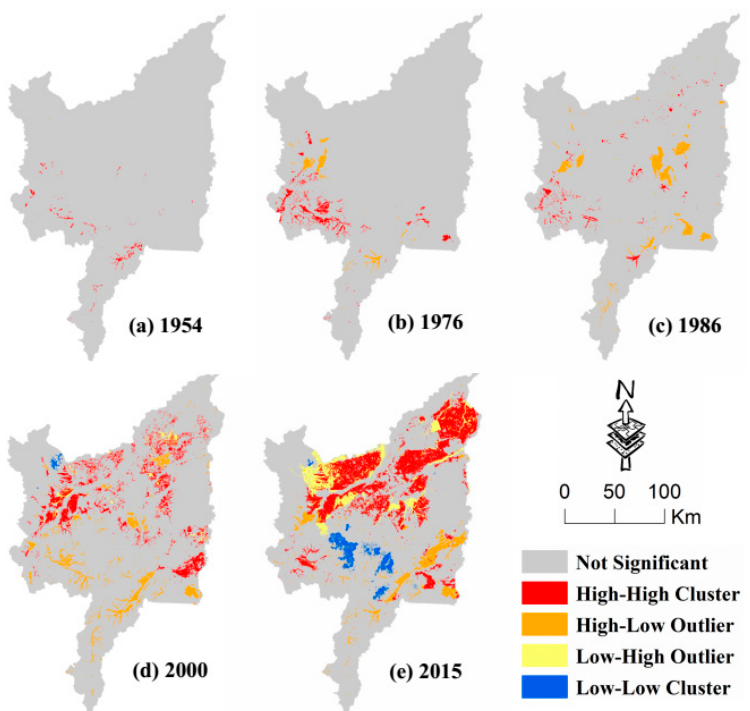
Figure 7. Spatial aggregation of paddy fields from 1954 to 2015. ( a ) 1954; ( b ) 1976; ( c ) 1986; ( d ) 2000 and ( e ) 2015.